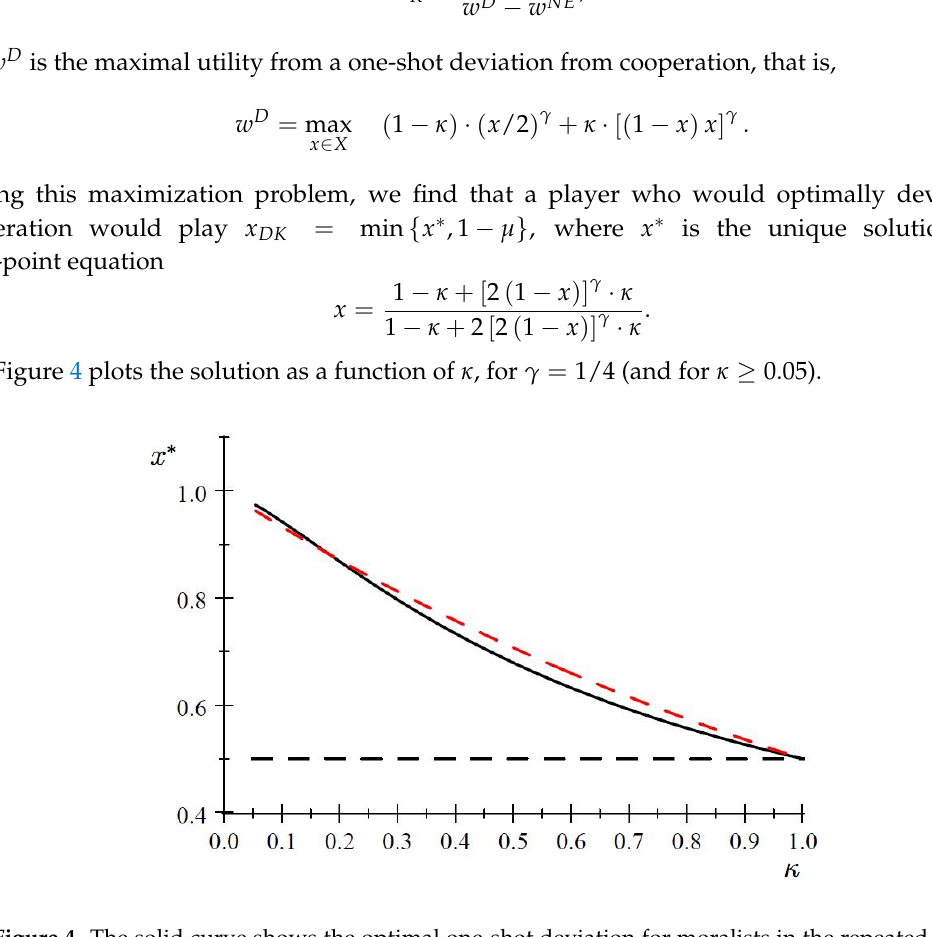
Figure 4. The solid curve shows the optimal one-shot deviation for moralists in the repeated game. The dashed curve shows an